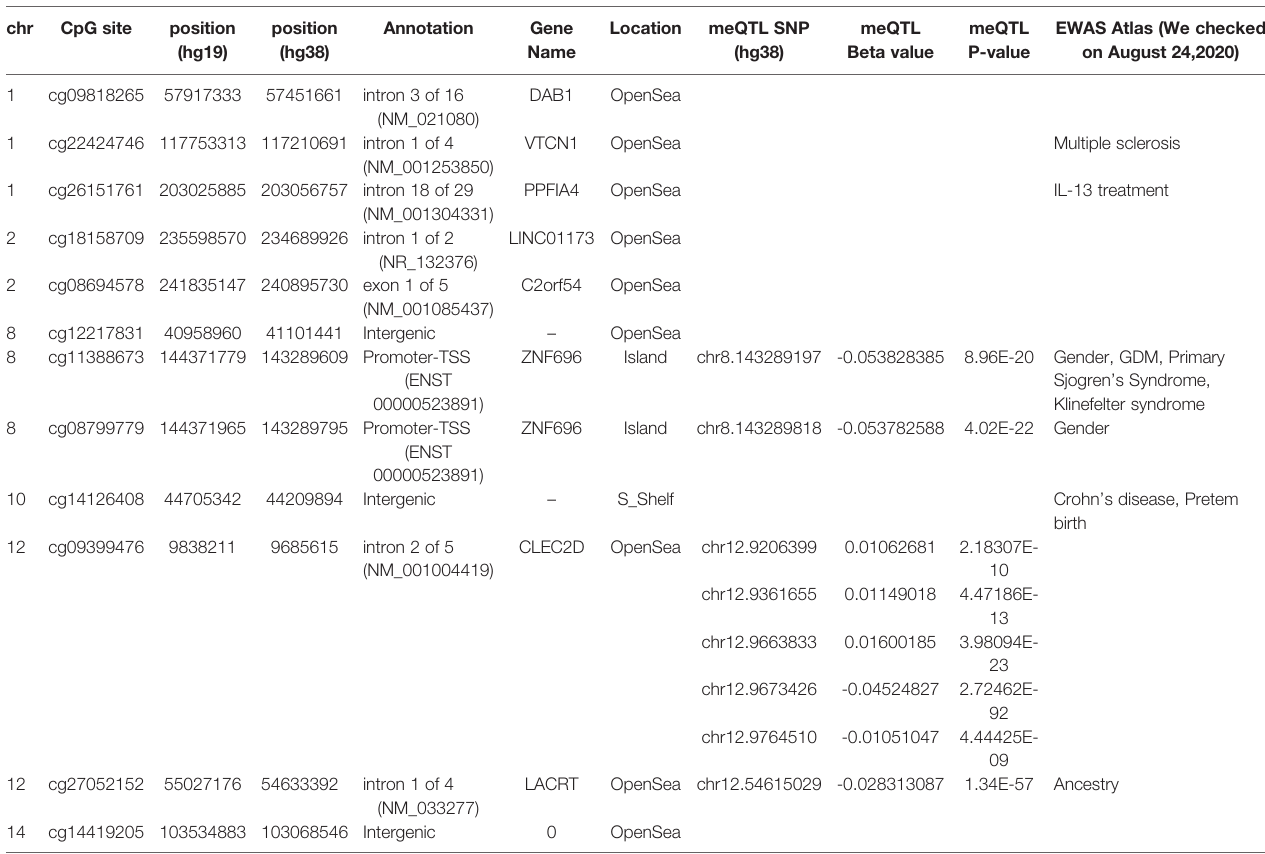
TABLE 4 | Outputs from mQTL database and EWAS Atlas for identi fi ed 12